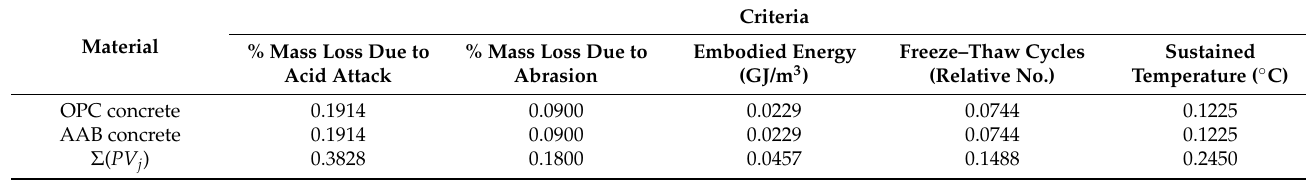
Table 5. Preference variation value ( PV j